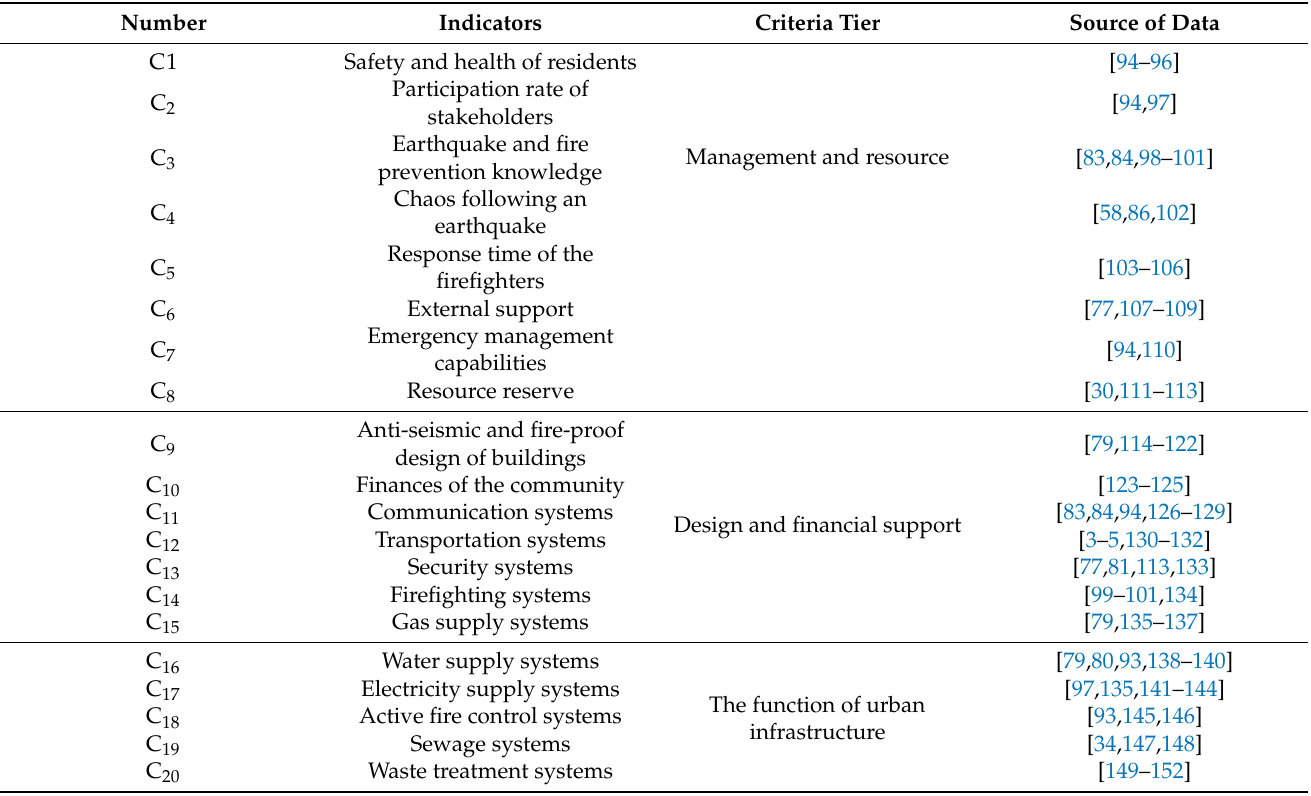
Table 1. Indicators on community resilience adapted to